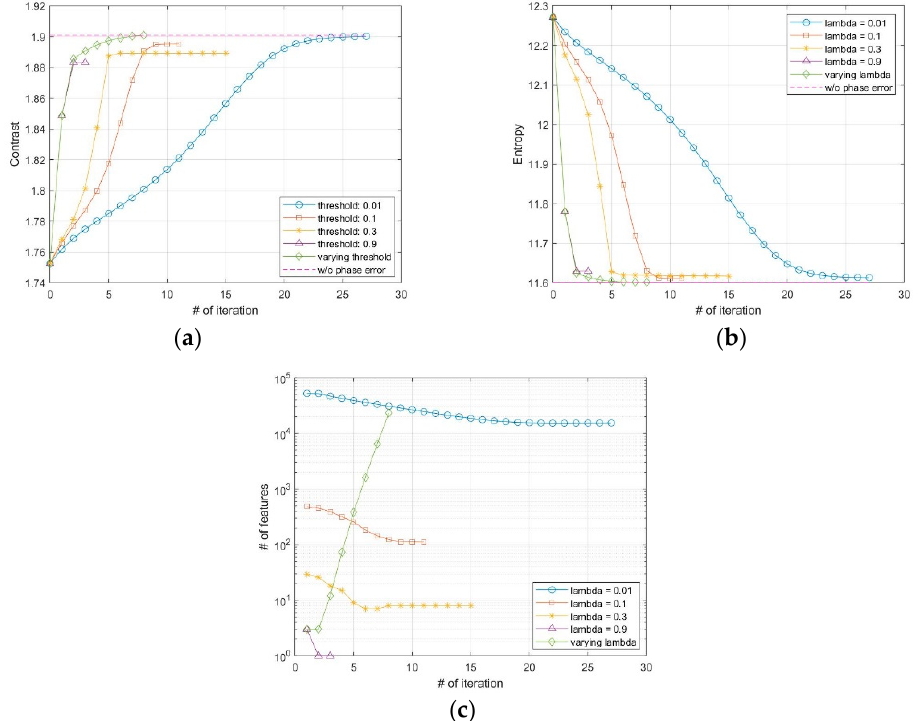
Figure 5. Variation of the quantitative measures of ( a ) contrast, ( b ) entropy, and ( c ) the number of features at each